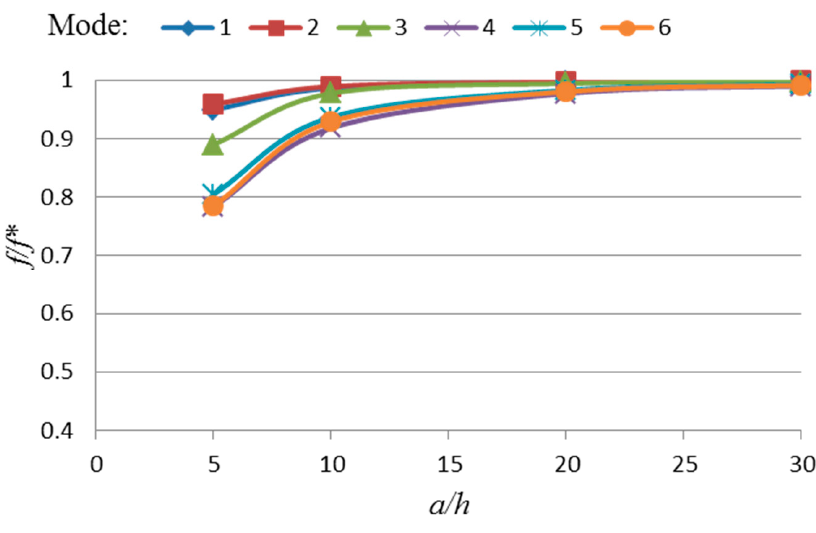
Figure 4. Relationship between normalized natural frequency and length-to-thickness ratio for the carbon/epoxy [0] 8 square plate.